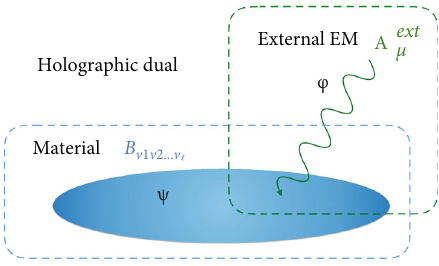
Figure 1: Schematic view of holographic duals to superconductivity: a material represented by a fi eld of spin ℓ whose EM properties are probed by an external fi eld living in a higher-dimensional spacetime. The dynamics of these two fi elds is captured by ψ and ϕ ,